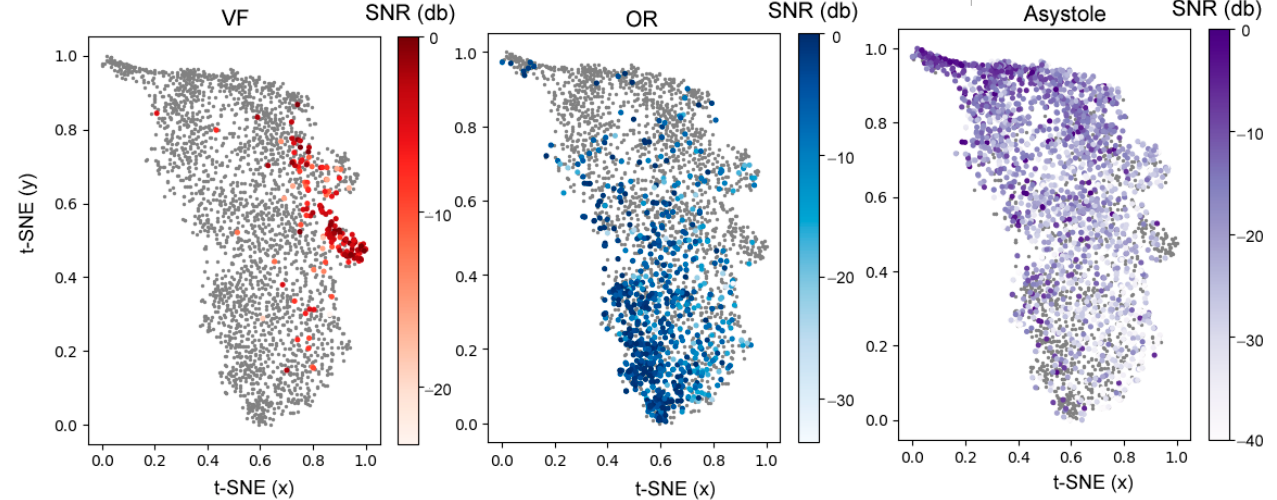
Figure 11. 2D t-SNE distribution of GMP features in CNN3-CC-ECG network, estimated for the test database for different rhythms (OR, Asystole, VF). The color gradients represent the distribution of the features with respect to SNR.